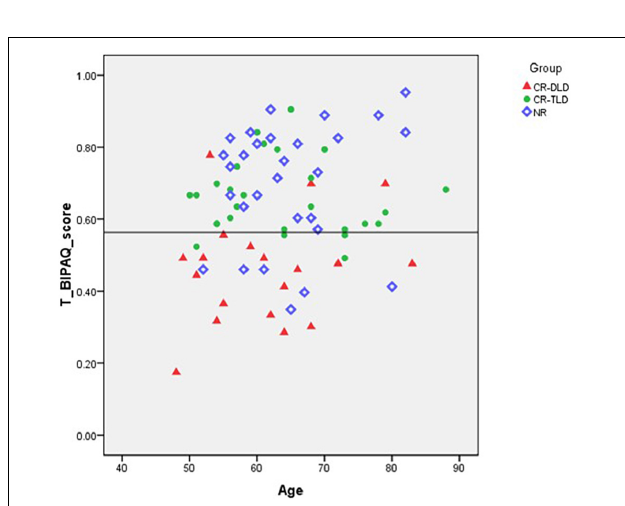
FIGURE 3 | Reported performance by age, for individual children within each group.